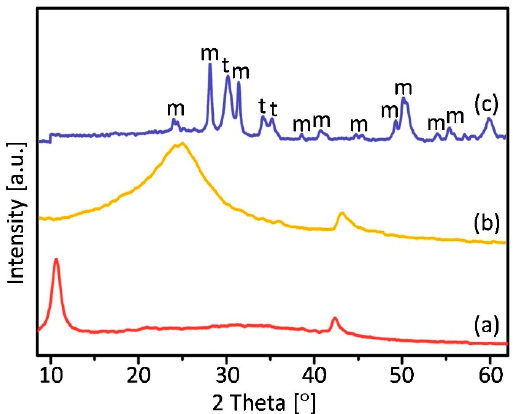
Figure 1. XRD patterns of ( a ) GO ( b ) rGO and ( c ) ZrO 2 /rGO materials, where “m” and “t” denote monoclinic and tetragonal zirconia, respectively.